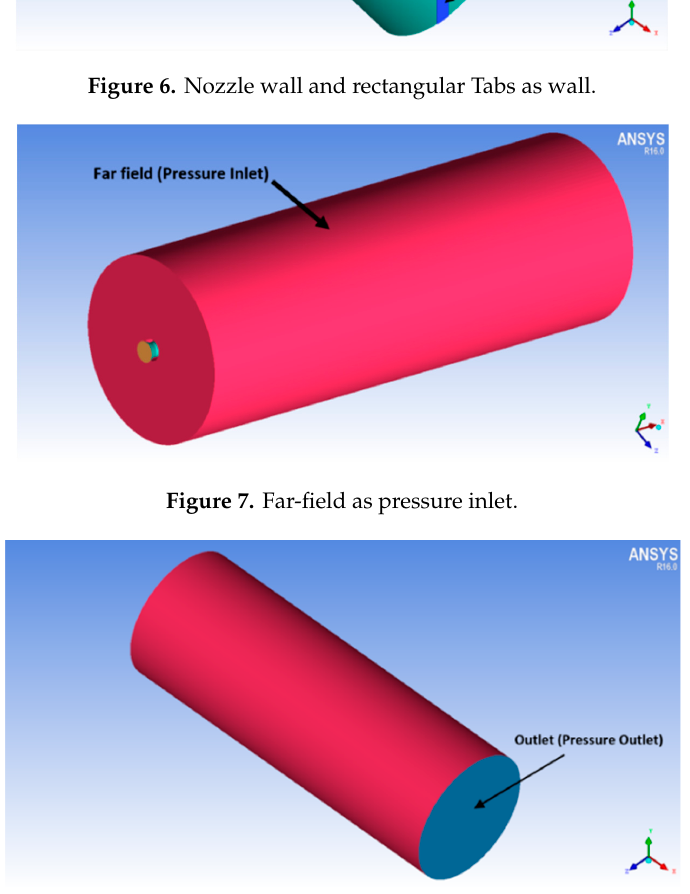
Figure 8. Domain outlet as pressure outlet.